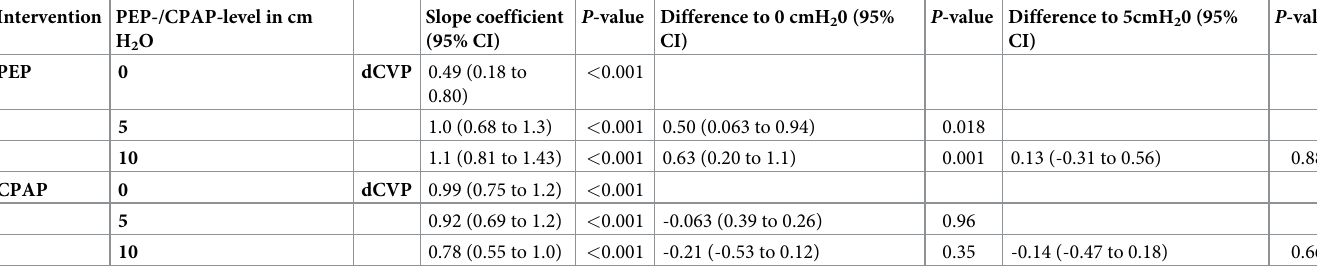
The slope coefficient of dCVP for each LBNP-level (0, 20, 40, 60 and 80) during different levels of PEP and CPAP, and comparisons between the PEP and CPAP levels. dCVP : respiratory variations in central venous pressure, LBNP : lower body negative pressure, PEP : positive expiratory pressure, CPAP : continuous positive airway